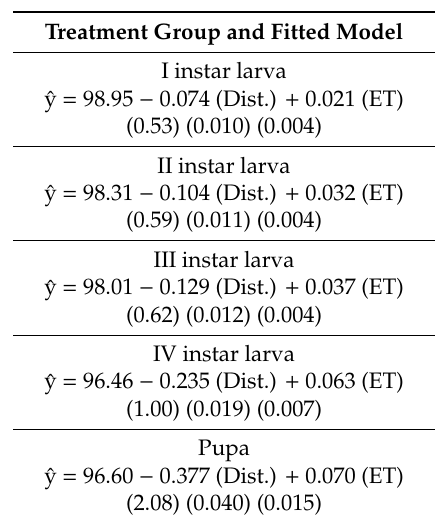
Table 2. Fitted mixed contribution model for mortality (ˆy) of mosquito young instars (%), evaluating the e ff ect of the distance from the source of sound waves (cm) and the exposure time (s). The numbers in parentheses are standard errors of the estimated coe ffi cients shown above. Dist. = distance, ET = exposure